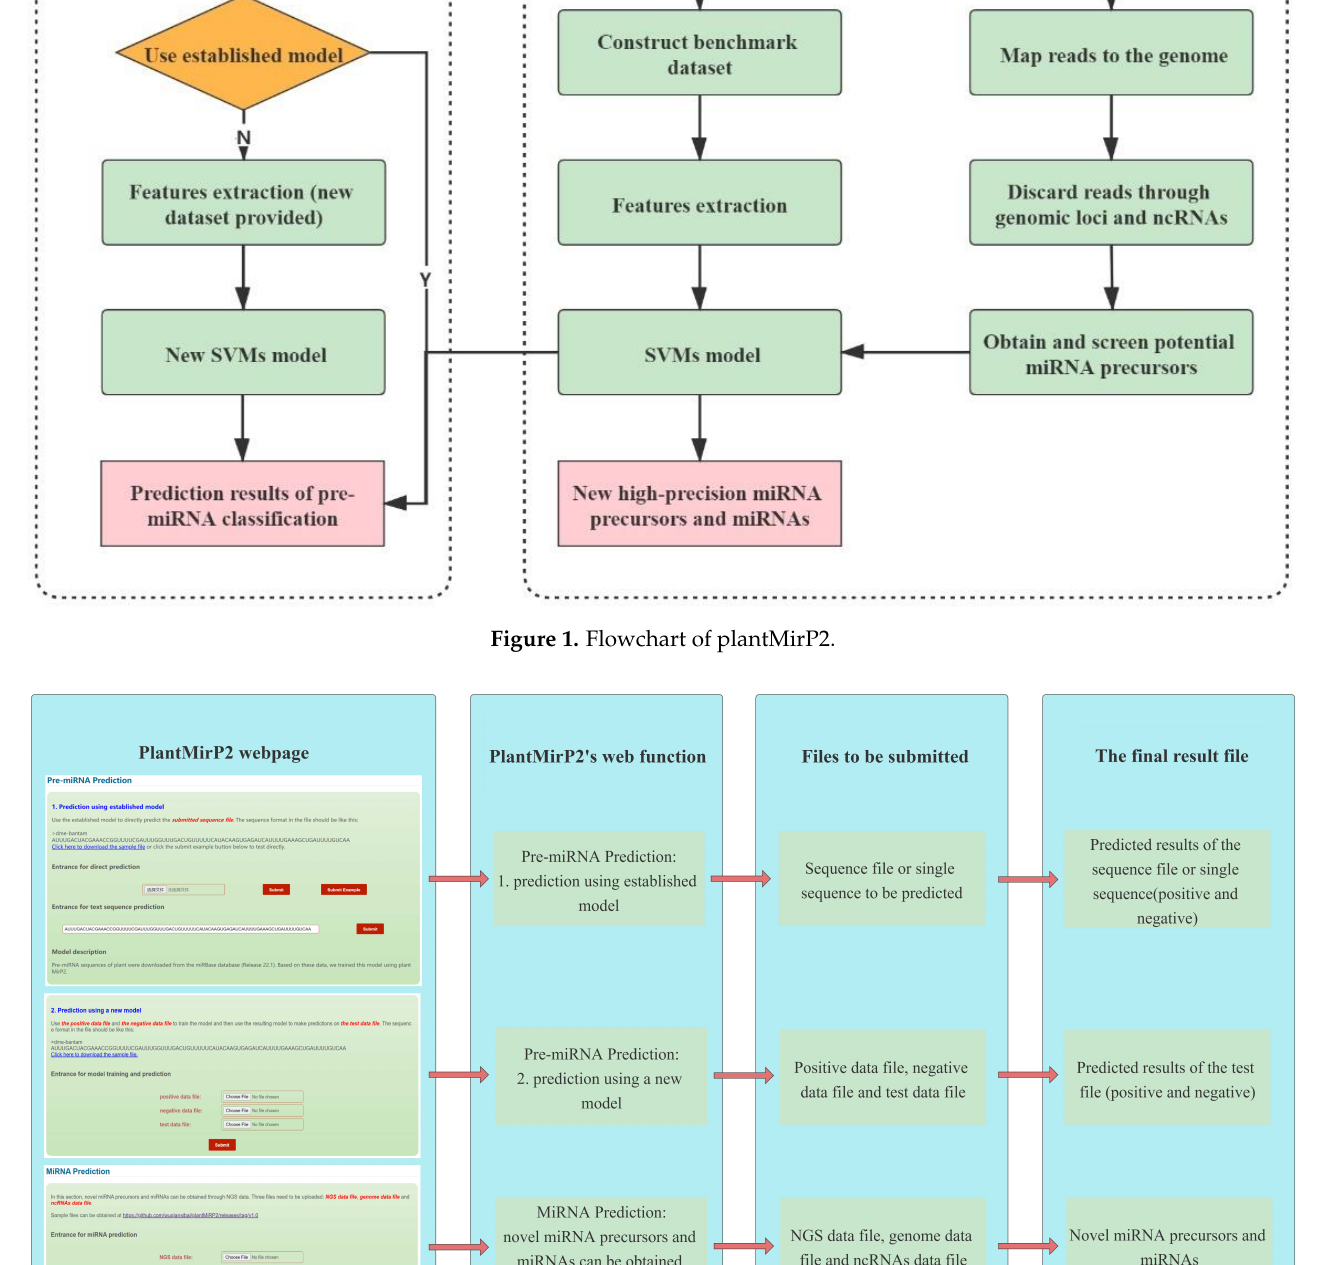
Figure 2. Webpage description and function introduction of plantMirP2′ s webserver.